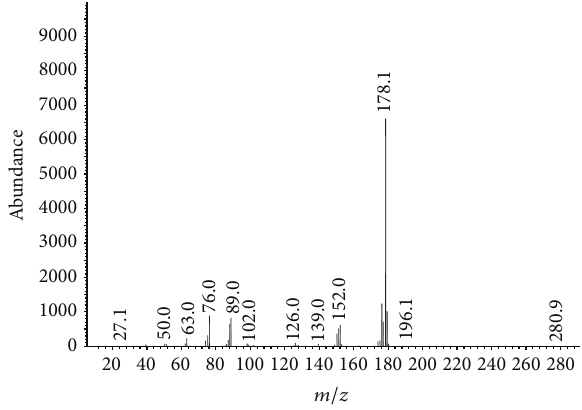
Figure 6: The mass spectrogram of 12.443 min.